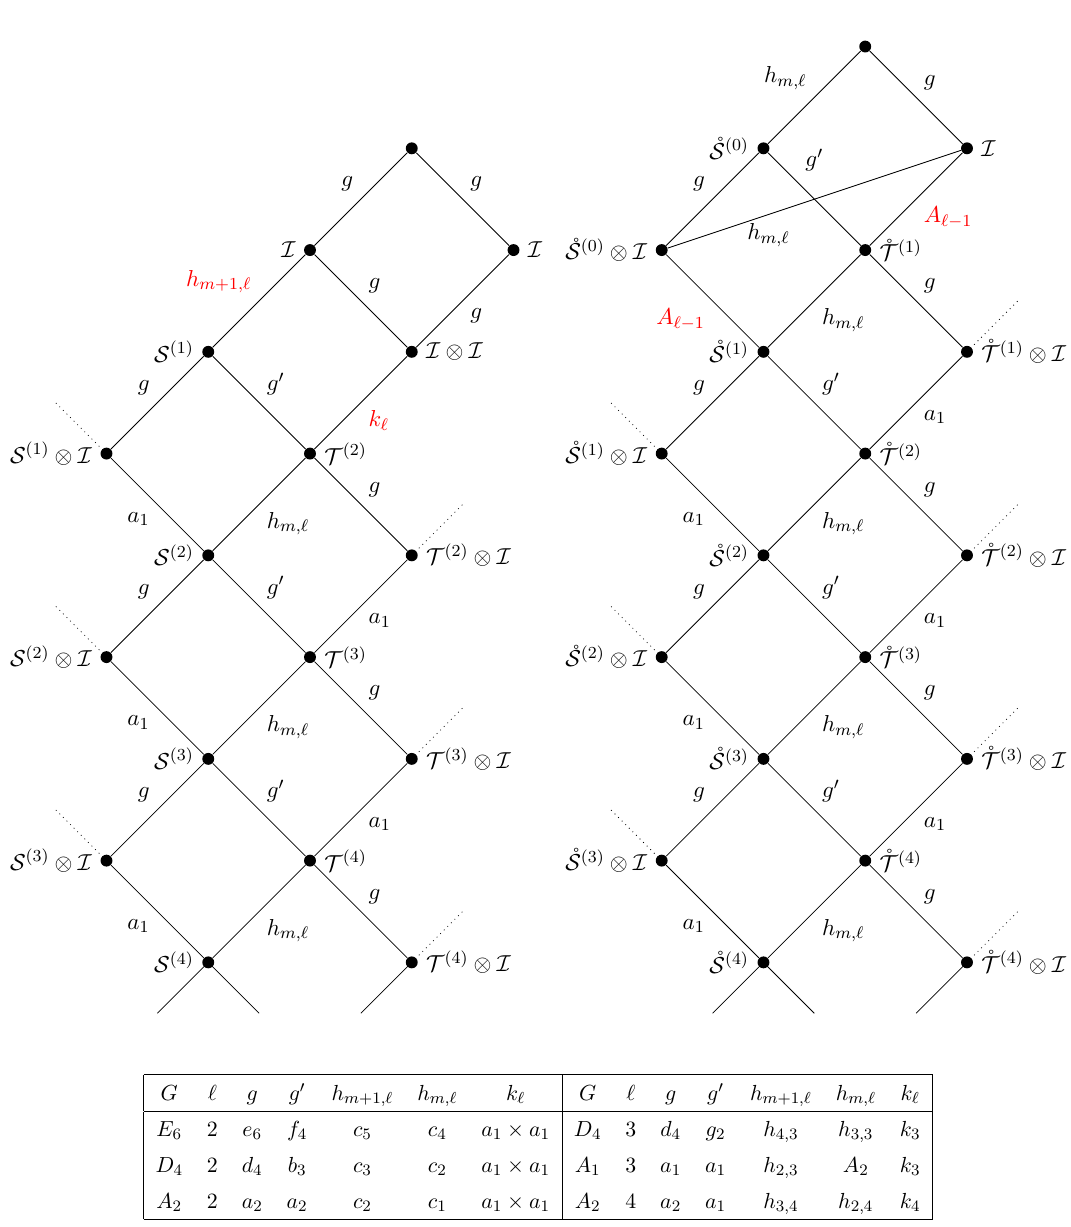
and T ( r ) theories (left) and ˚ S ( r ) and ˚ T ( r ) Figure 12. Part of the Hasse diagrams of the S ( r ) G,‘ G,‘ G,‘ G,‘ theories (right). Each vertex v is a symplectic leaf, and is labeled by the name of a 4d theory T , in such a way that the Hasse diagram for the Higgs branch of T is the subdiagram made of all the leaves above v . Black lines show transitions as given by the table, these are elementary transitions except for k which is an a diamond (see figure 14 for explicit drawing). The dotted lines show 2 1 × a 1 transitions to leaves which are not represented (the diagrams of S (1) , T (2) , ˚ S (0) , ˚ S (1) , and ˚ T (1) are G,‘ G,‘ G,‘ G,‘ G,‘ therefore complete). The highest r -value displayed is 4 , but the diagrams are infinite towards the bottom. Elementary transitions other than g , g 0 , a and h are shown in red for ease of 1 m,‘